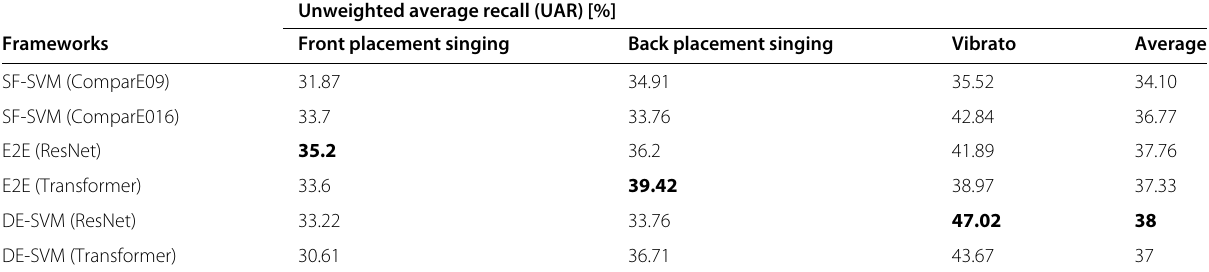
Table 5 Different frameworks’ UAR result for classification subtasks of three 3-class paralinguistic singing attributes Unweighted average recall (UAR) [%]